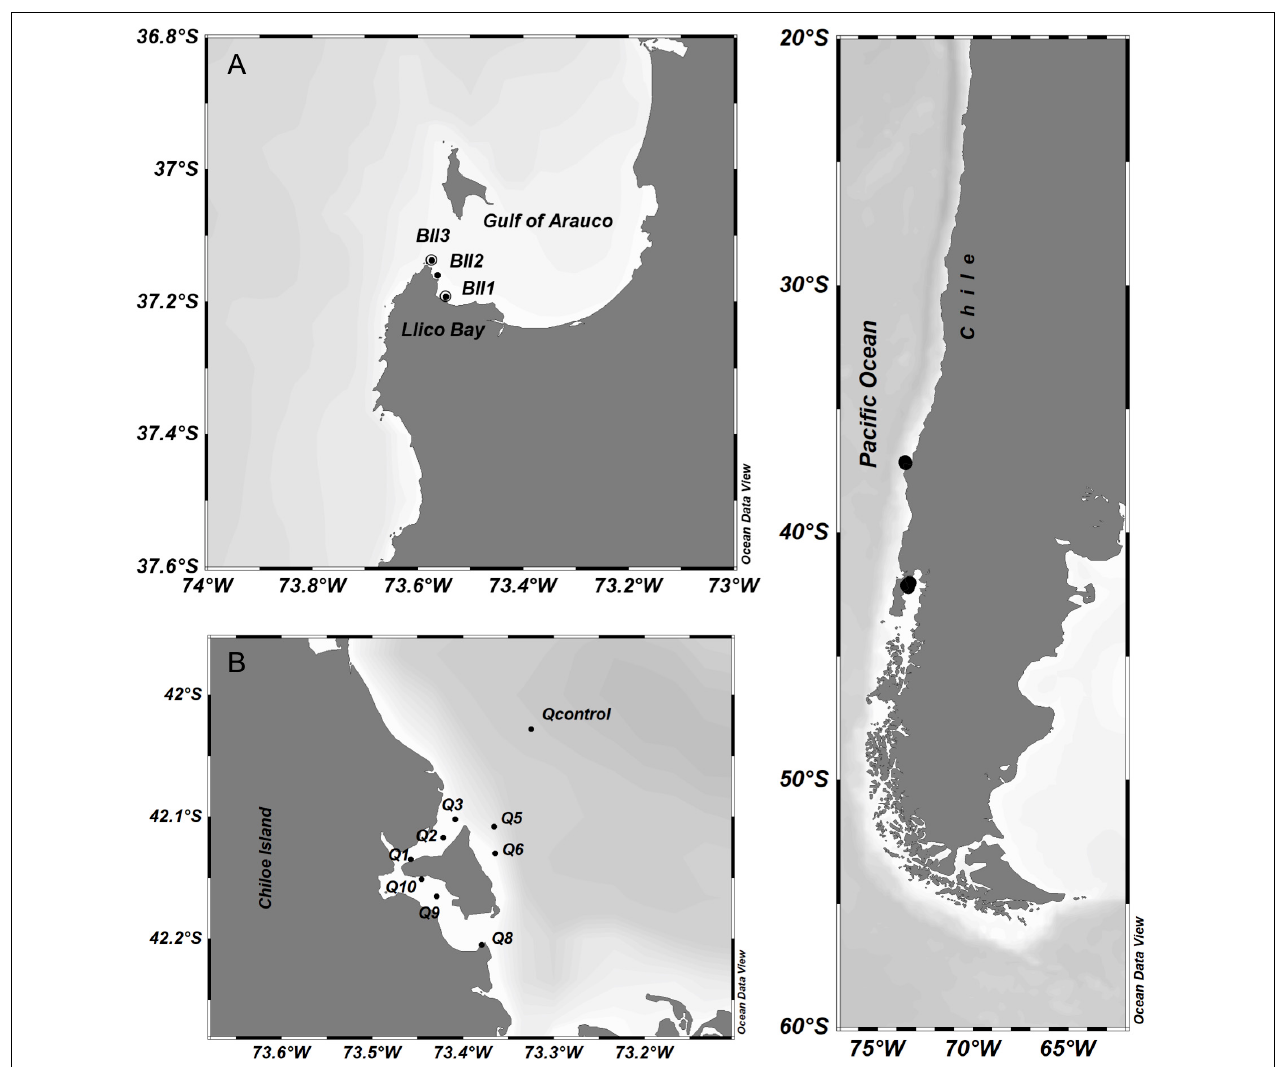
FIGURE 1 | Study area in central-southern and Norther Patagonia Chile showing the sampling location in (A) Llico Bay in Gulf of Arauco and (B) Caucahue channel in the inner sea of Chiloé. Circles indicate sampling stations.